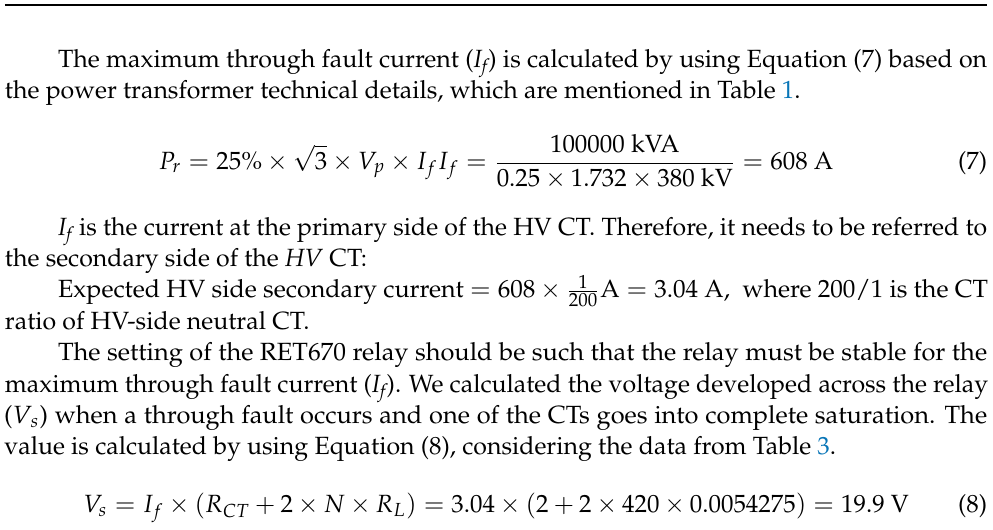
Table 3. Parameter details for single-phase high-impedance differential protection. Parameter Value Parameter Value CT resistance ( R CT ) 2 Ω CT knee point ( V K ) 400 V CT cable lead resistance per Maximum CT lead 420 0.0054275 Ω /m cable length ( N ) meter ( R L )